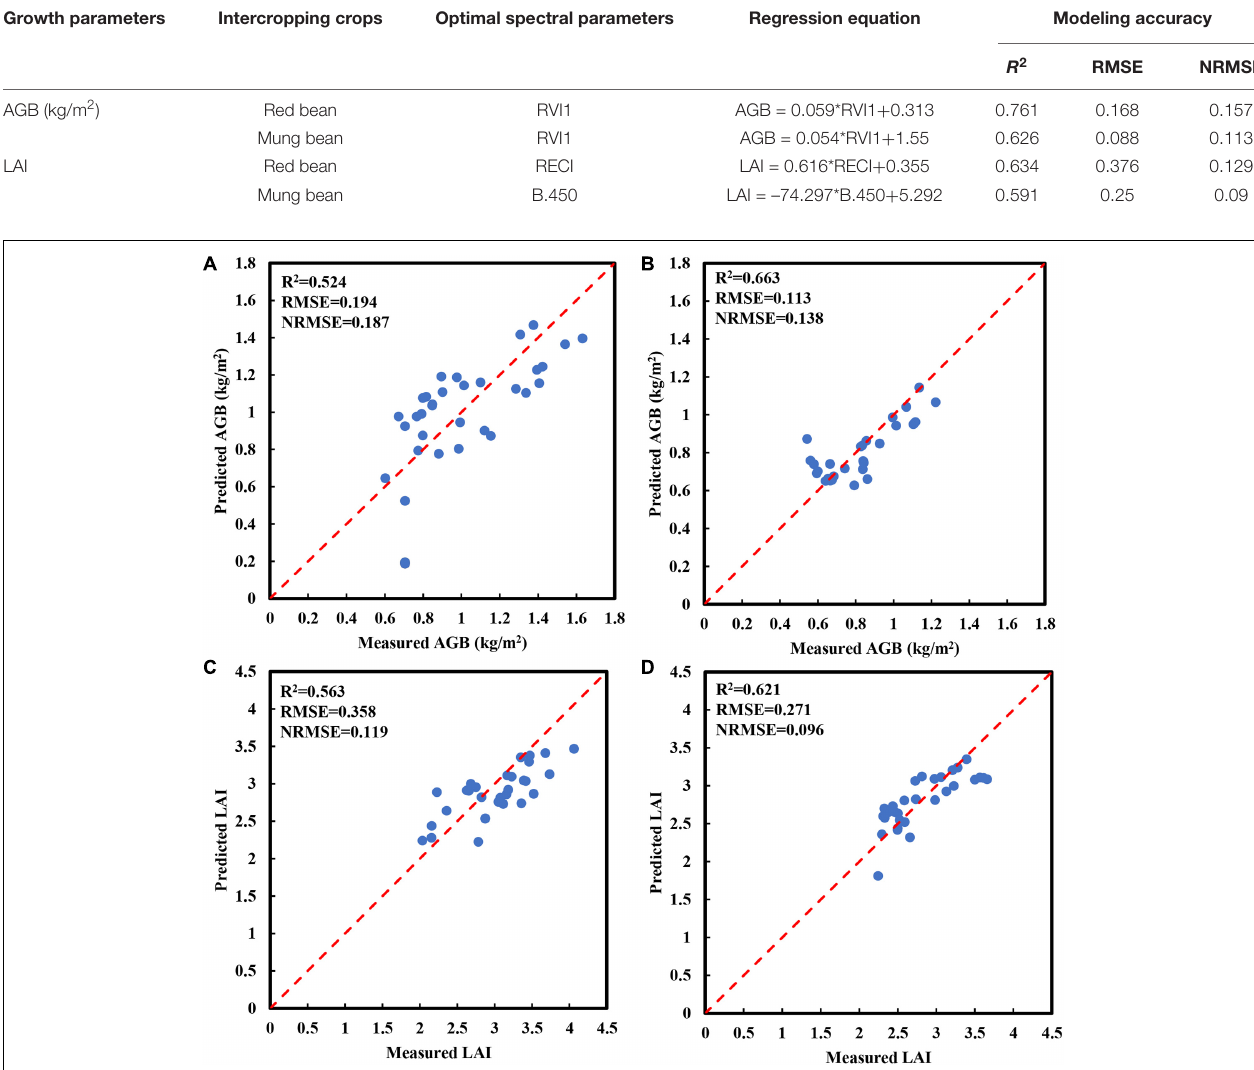
TABLE 3 | Performance indicators of the AGB and LAI estimation models established by the LR method using the optimal spectral parameters in the training set. Growth parameters